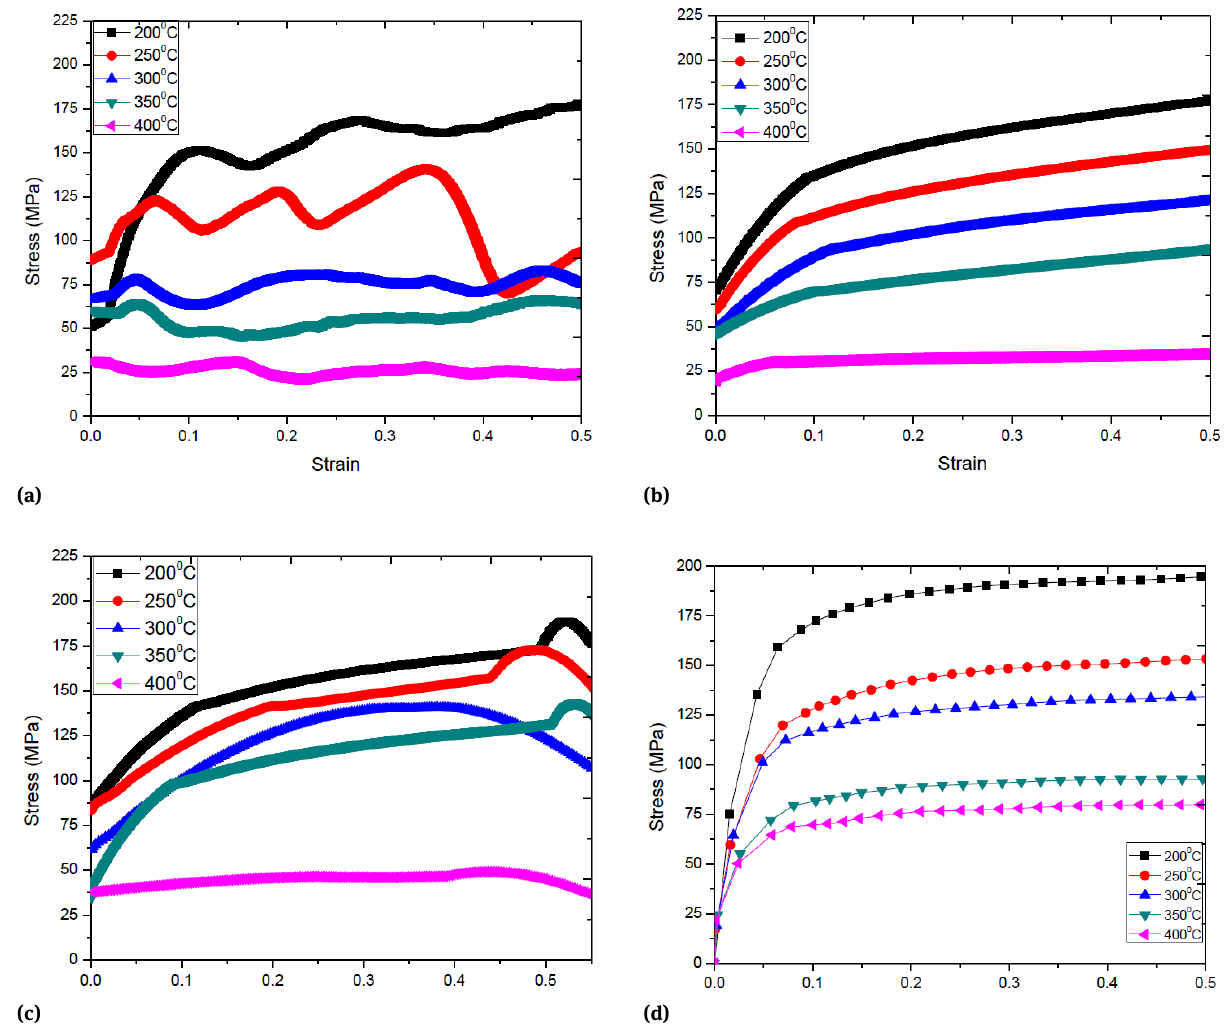
Figure 1: True stress-true strain curves of Al6063/6 wt.% steel p composite under different compression conditions: (a) 0.01 s –1 ; (b) 0.1 s –1